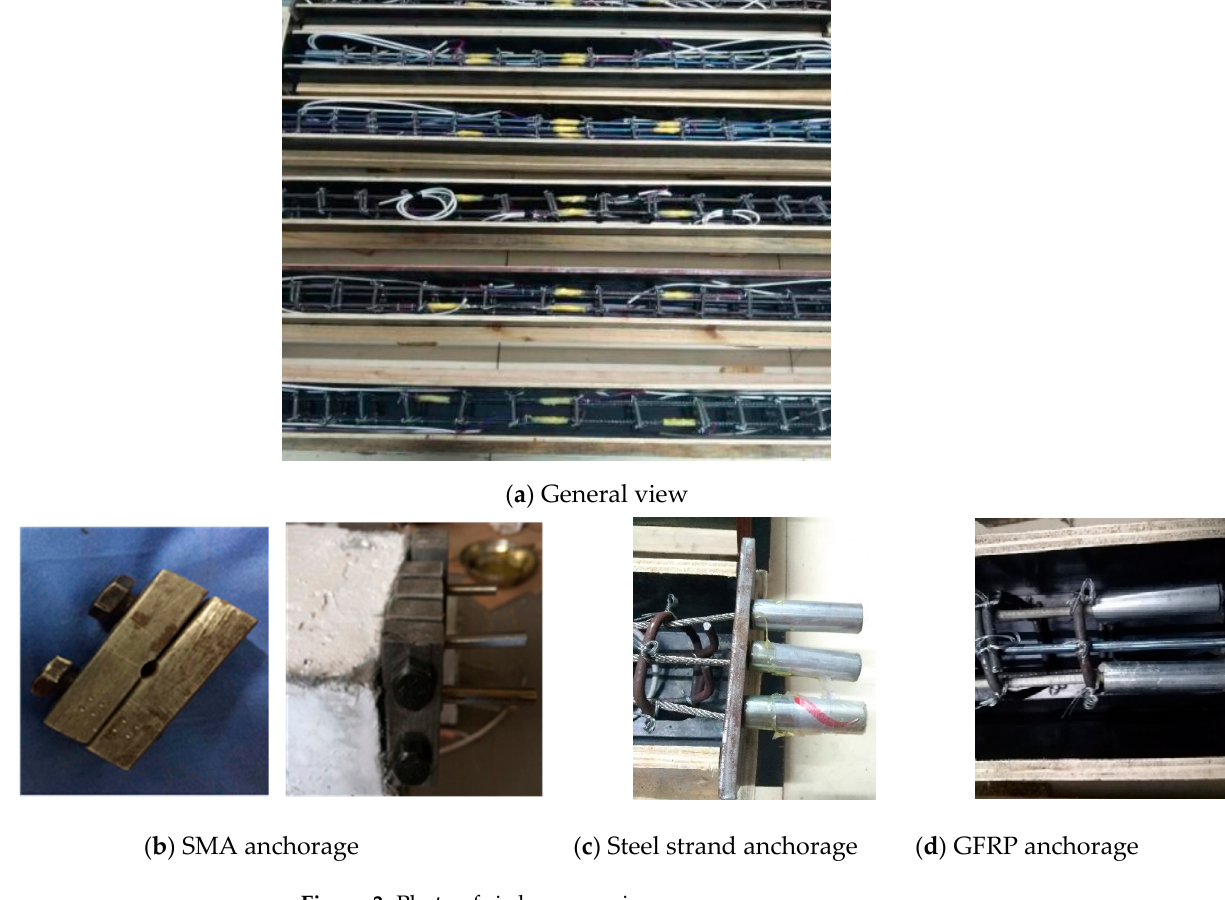
Figure 3. Photo of six beam specimens.